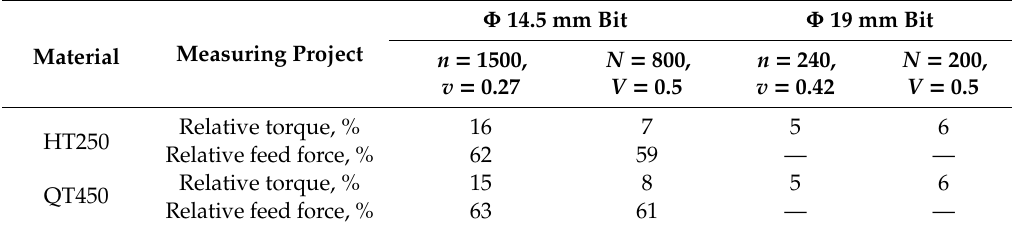
Table 8. Relative torque and relative feed force on the drilling